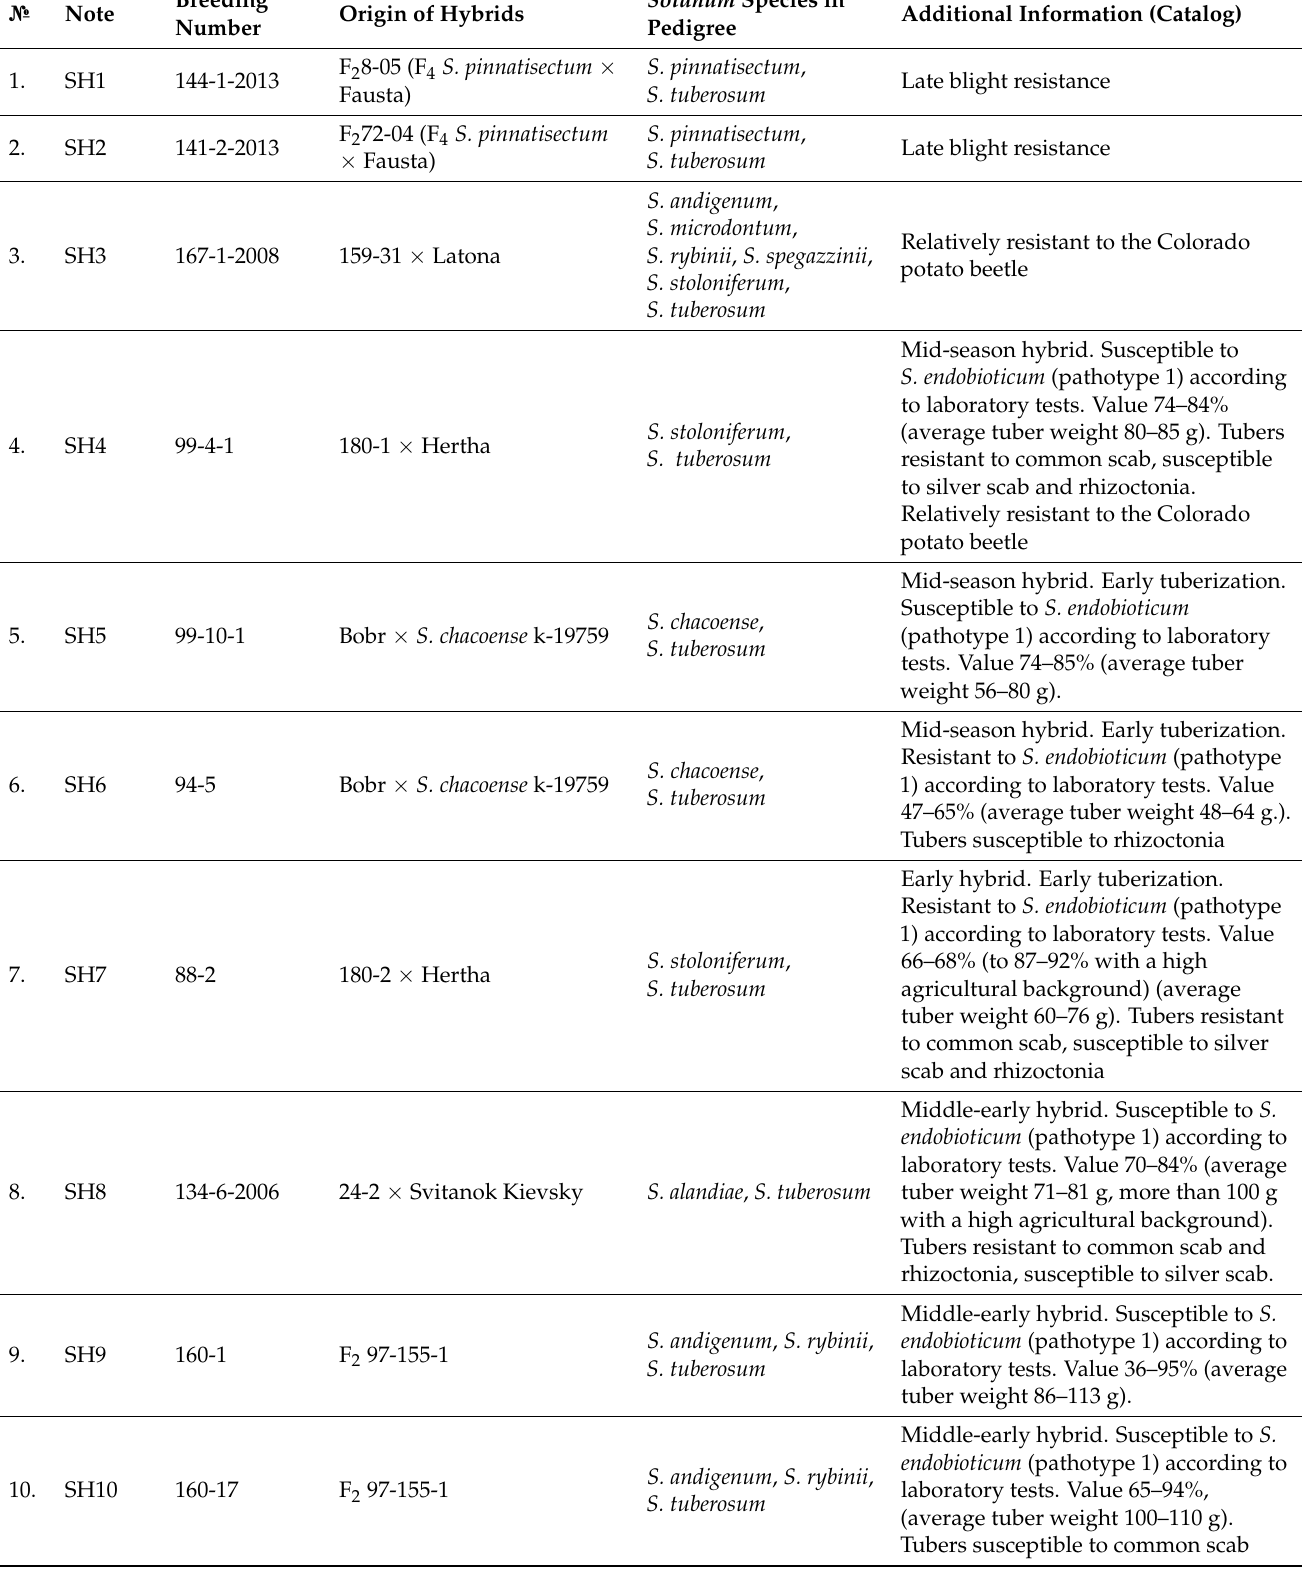
Table 1. Hybrid’s origin and